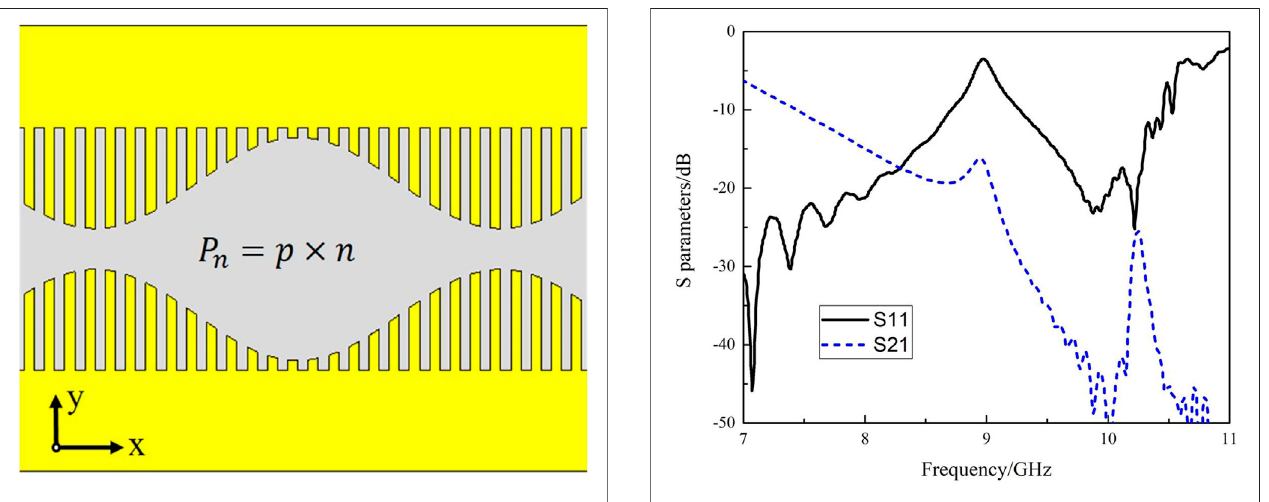
FIGURE 5 | The simulated S parameters of the LWA based on